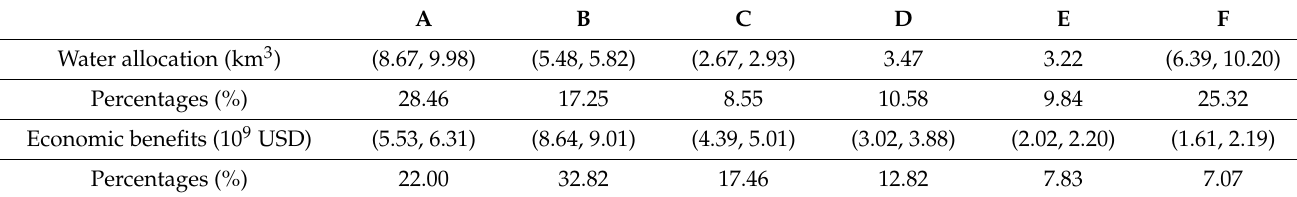
Table 16. Water allocation and economic benefits by